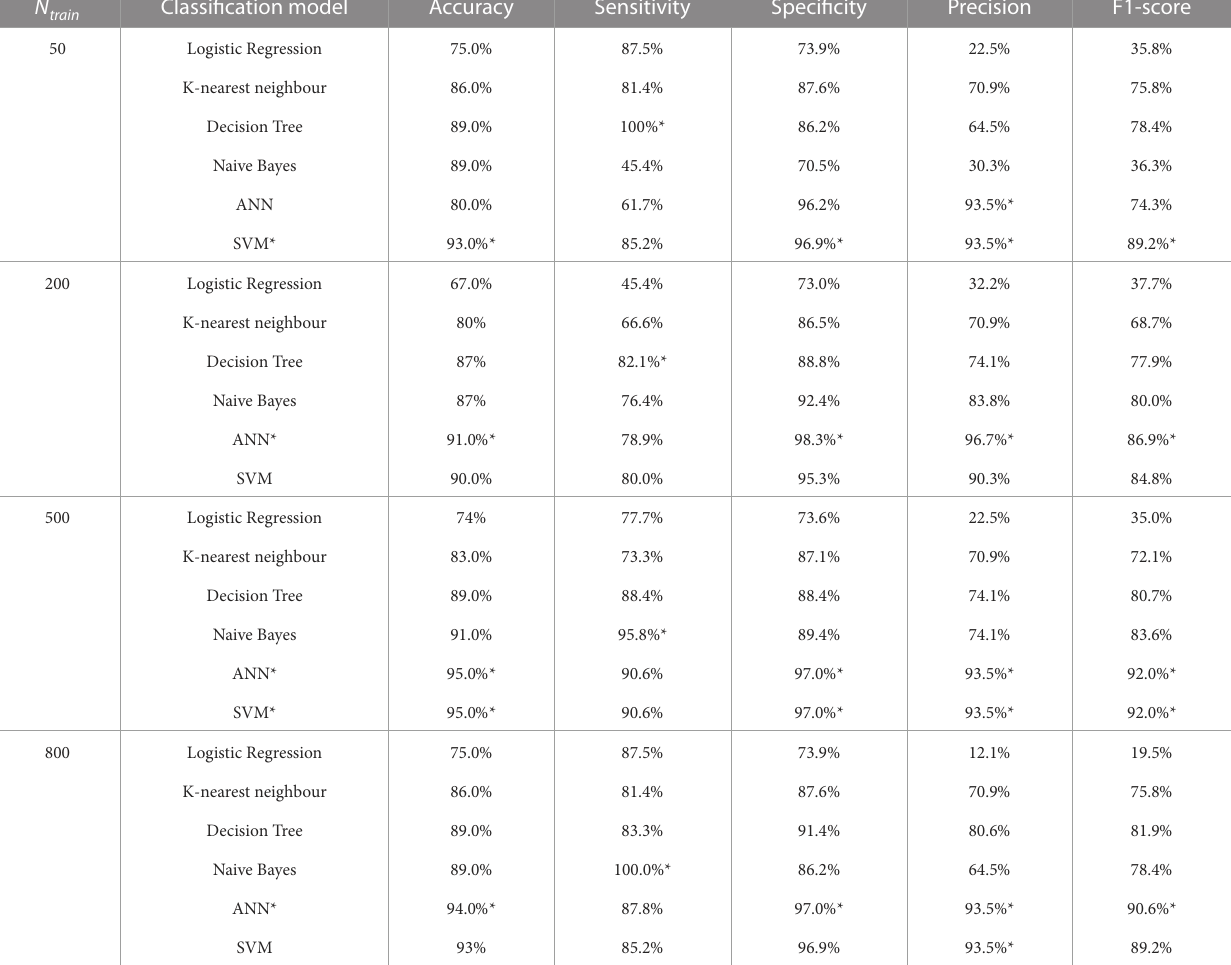
TABLE2 Analysisofclassifiersperformance.EvaluationmetricsofthesixMLmodelsfor N train = { 50 , 200 , 500 , 800 } .Thebestresultforeachcategoryis highlighted. N